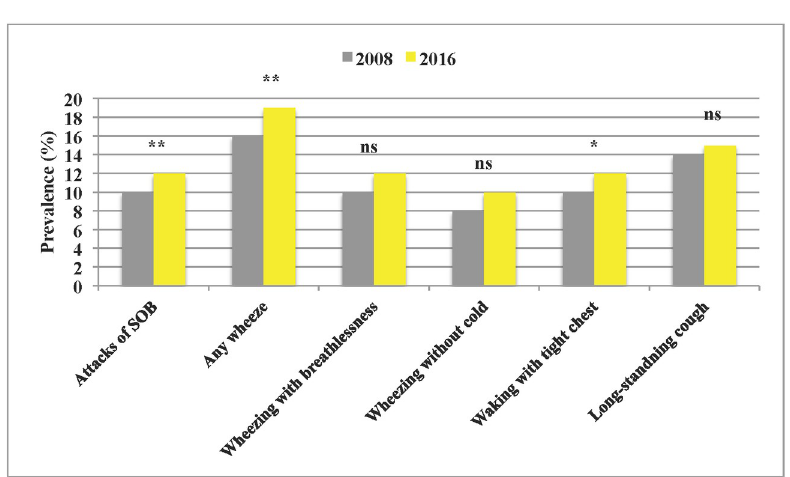
Fig 2. Respiratory symptoms in 2008 and 2016. The prevalence of respiratory symptoms during the last 12 months in 2008 and 2016. SOB = shortness of breath, � p < 0.05, �� p < 0.01, ��� p < 0.001 and ns = not significant.